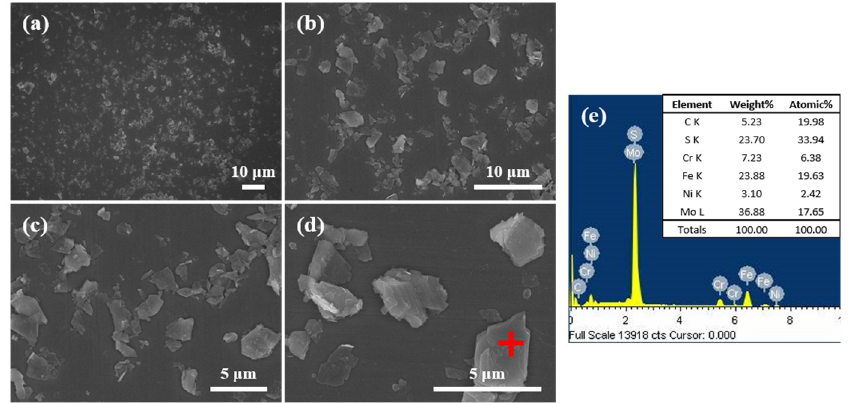
Figure 2. Surface morphology of sunflower oil (SunFO) with molybdenum disulfide (MoS 2 ) coating on the stainless steel (SS) observed by SEM and EDS: ( a ) 1000×, ( b ) 3000×, ( c ) 5000×, ( d ) 10000×, ( e ) EDS results on the red spot.